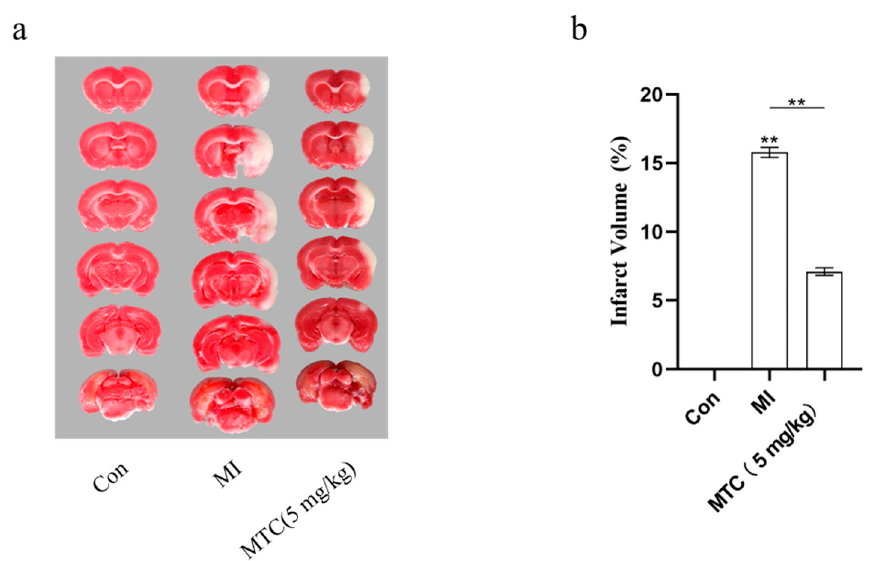
Figure 8. ( a ) Brain section stained with 2,3,5-triphenyltetrazolium chloride (TTC) in different groups. The white area represents the infarct part, and the red area represents the normal part. ( b ) Quantitative analysis of cerebral infarct volume, ** p < 0.01.